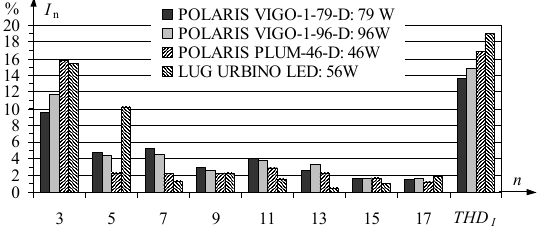
Fig.2. Percentage of higher current harmonics and THD I drawn from a low-voltage power grid by industrial LED bulbs.